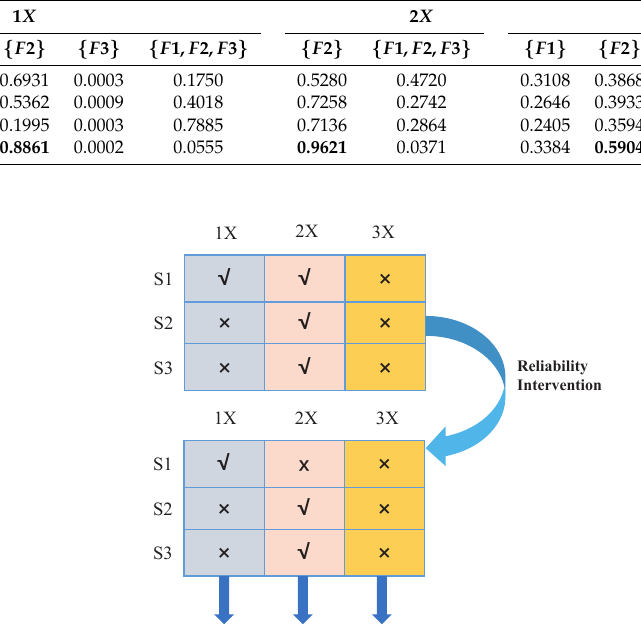
Table 10. The modified BPA and the result of the evidence fusion with Dempster’s combination rule.